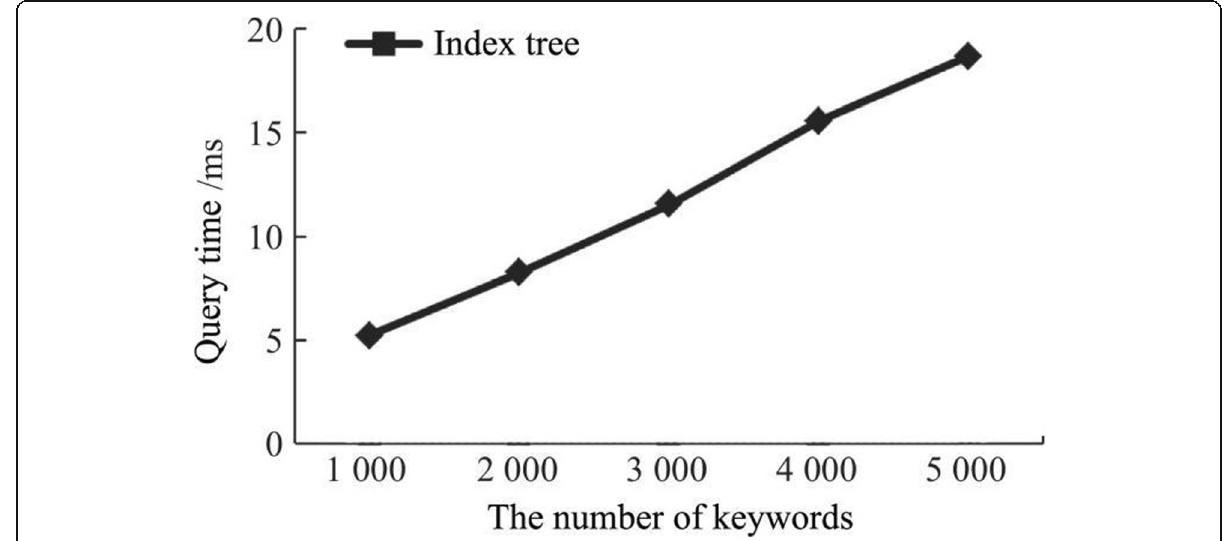
Fig. 15 Time of searching. shows the increase in the query time with the number of keywords